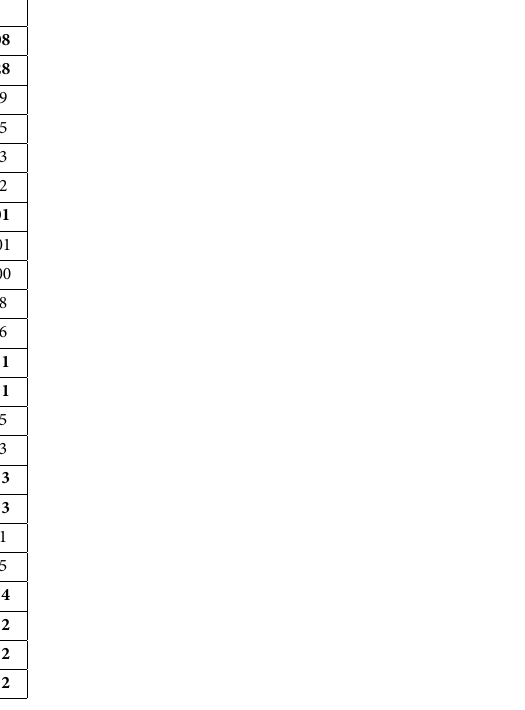
Table 11. The Std values of dimensions are equal to 50 and 100. The best of the comparison results are in [bold].